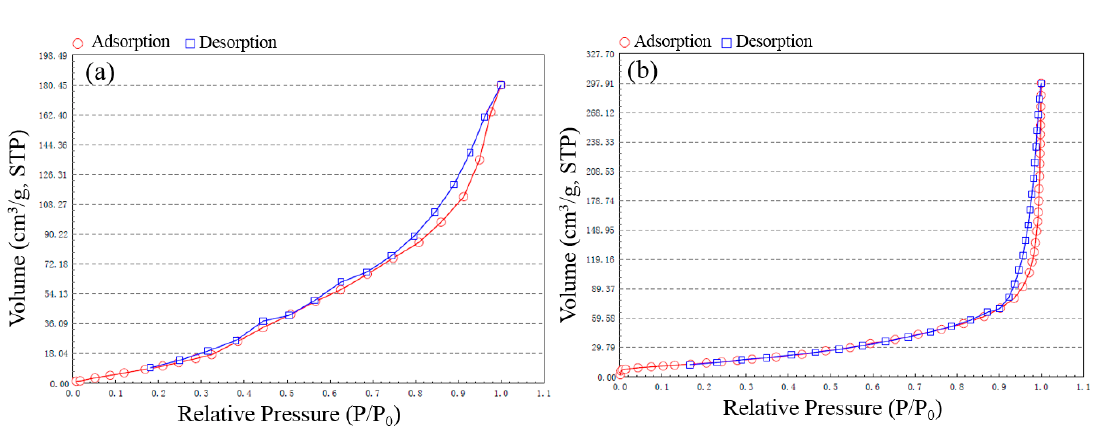
Figure 9. EDX spectra of ( a ) TiO 2 and ( b ) Gd-doped TiO 2 nanotubes